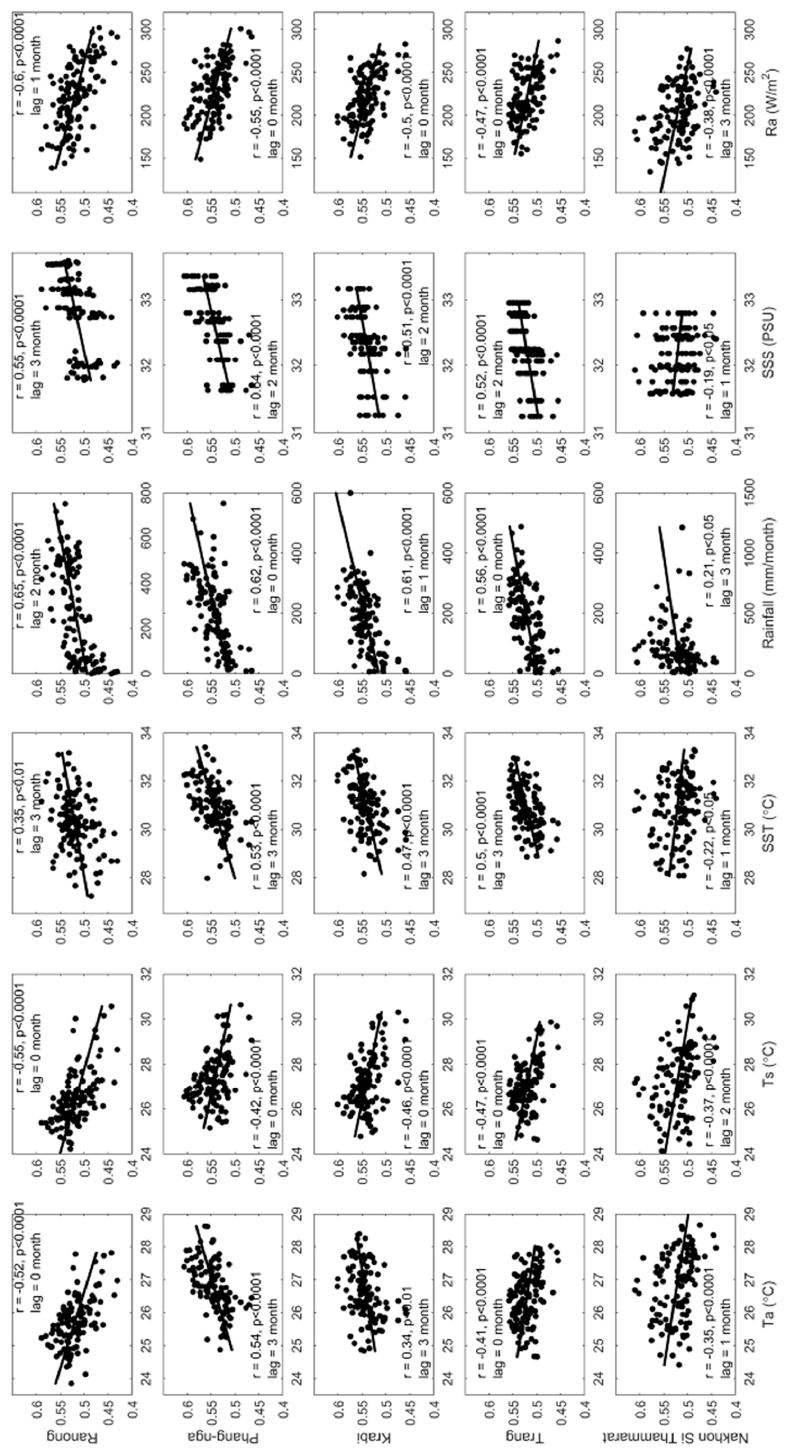
Figure 10. Scatterplot of monthly relations between EVI and drivers, including air temperature (Ta), land surface temperature (Ts), sea surface temperature (SST), rainfall, sea surface salinity (SSS) and radiation (Ra) at the five study sites. The lag months quoted in the figure show the lag time that resulted in the highest (r 2 ) between the driver and the EVI (sometimes the slope is positive, positive r and sometimes negative, negative r). For example, if the driver data is in January, the EVI response will be in March if the lag time is 3